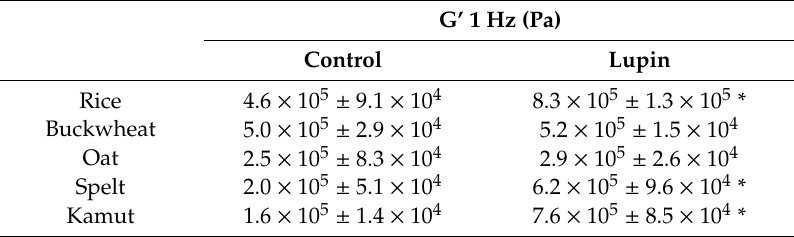
Table 2. Values of G’ when the frequency corresponds to 1 Hz. Values are the means of at least three experiments ± SD. * represents p < 0.05 when compared with the corresponding control